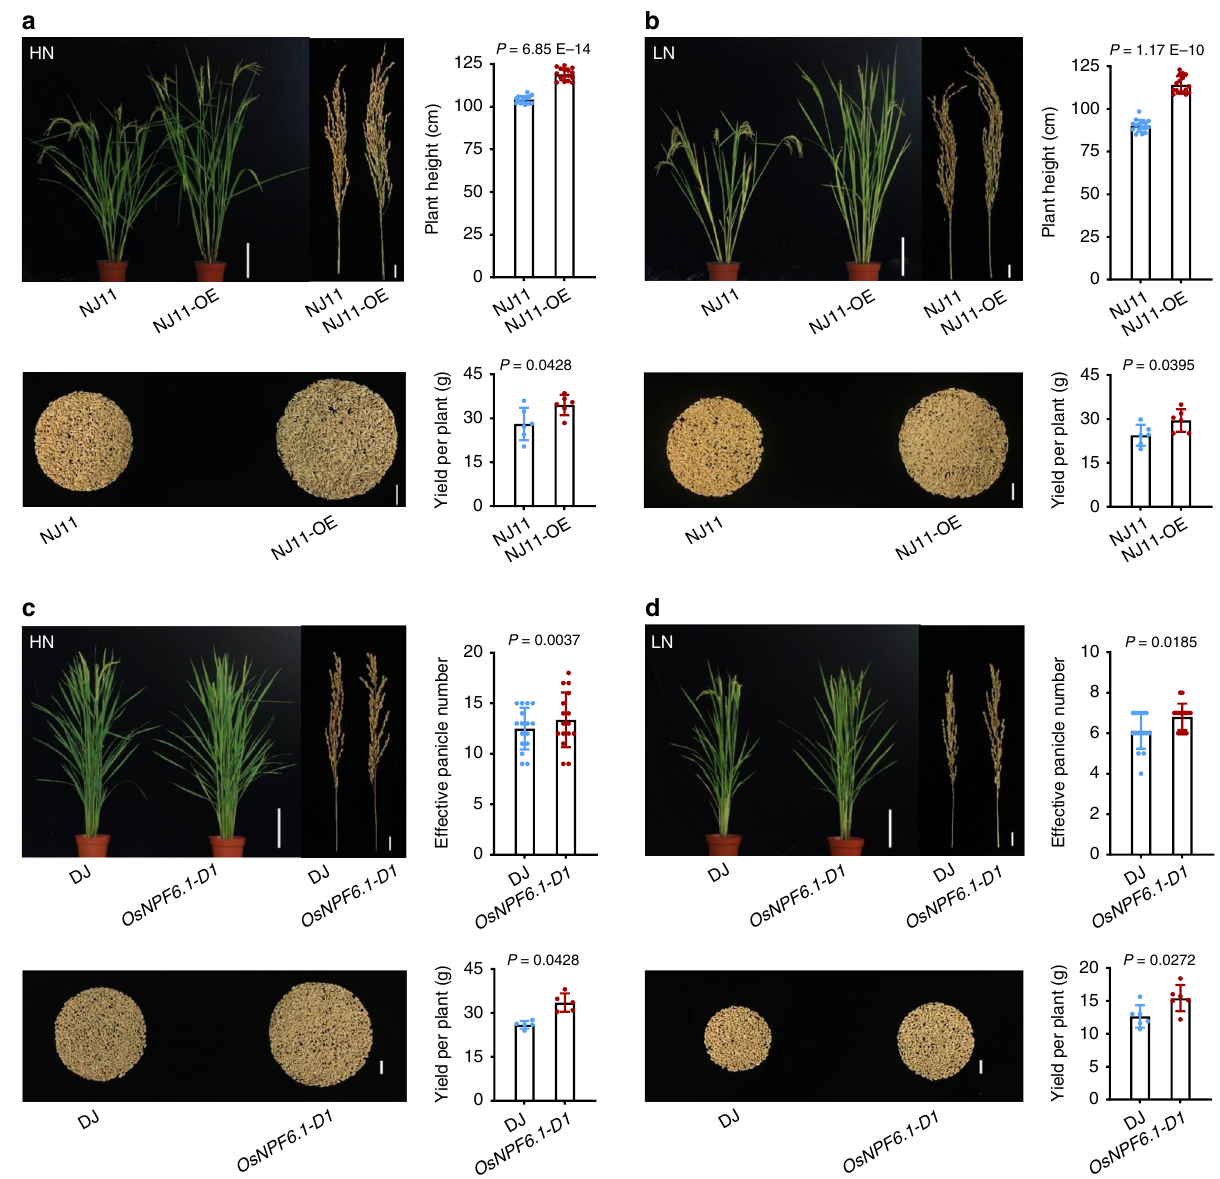
Fig. 3 Agronomic traits enhanced by ectopic expression of OsNPF6.1 . a , b Comparison of NJ11 and NJ11-OE plant heights under HN ( a ) and LN ( b ) conditions, bar = 20 cm (the plants), 2 cm (the panicles and the seeds), n = 16, 6. c , d Comparison of the effective panicle numbers at maturity of DJ and OsNPF6.1-D1 in HN ( c ) and LN ( d ) conditions, bar = 20 cm (the plants), 2 cm (the panicles and the seeds), n = 16, 5. Data are presented as means ± SD. P values (versus the NJ11 and DJ) were calculated with Student ’ s t test. NJ11, Nanjing11; DJ, Dongjin. Source data are provided as a Source Data fi